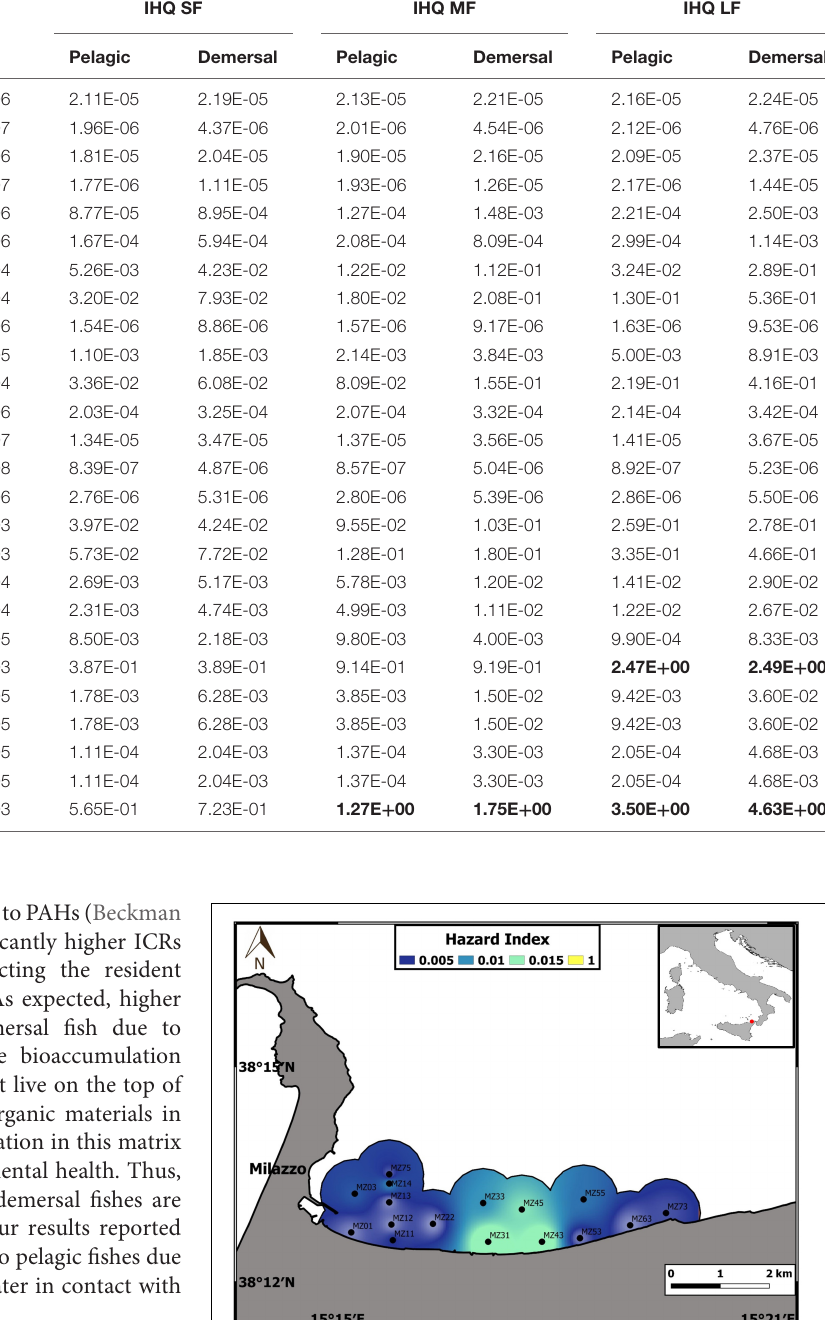
TABLE 6 | Ingestion Hazard Quotient (IHQ) for small (SF), medium (MF), large (LF) pelagic and demersal fishes, Dermal Hazard Quotient (DHQ) and Hazard Index (HI) as the sum of the HQs. Contaminant